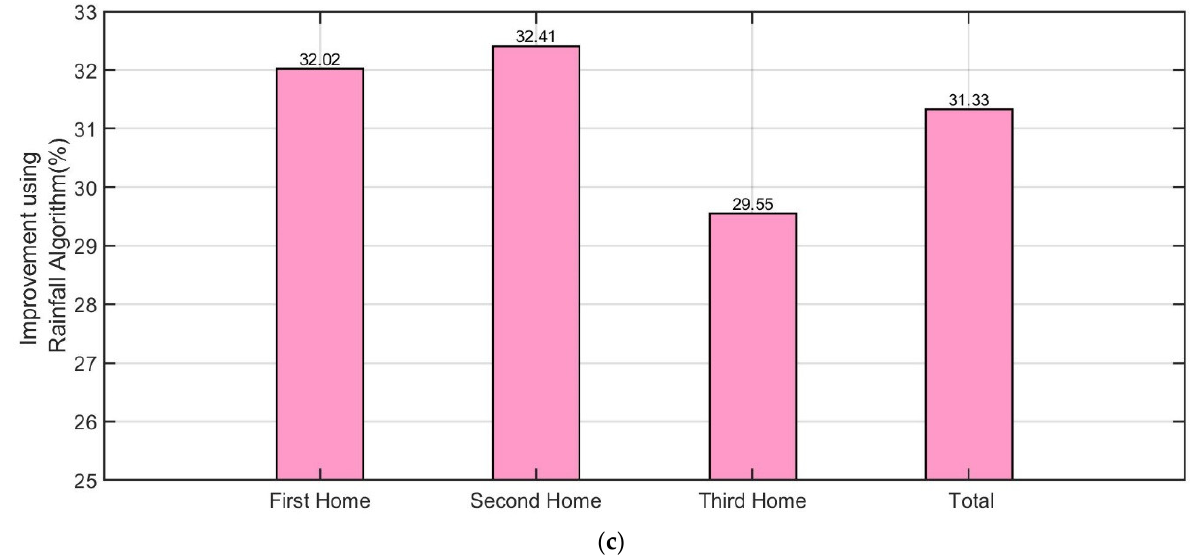
Figure 14. Comparison between without the suggested system and with the suggested system, ( a ) microgrid cost, ( b ) im- provement (%) by using salp swarm algorithm, ( c ) improvement (%) by using rainfall